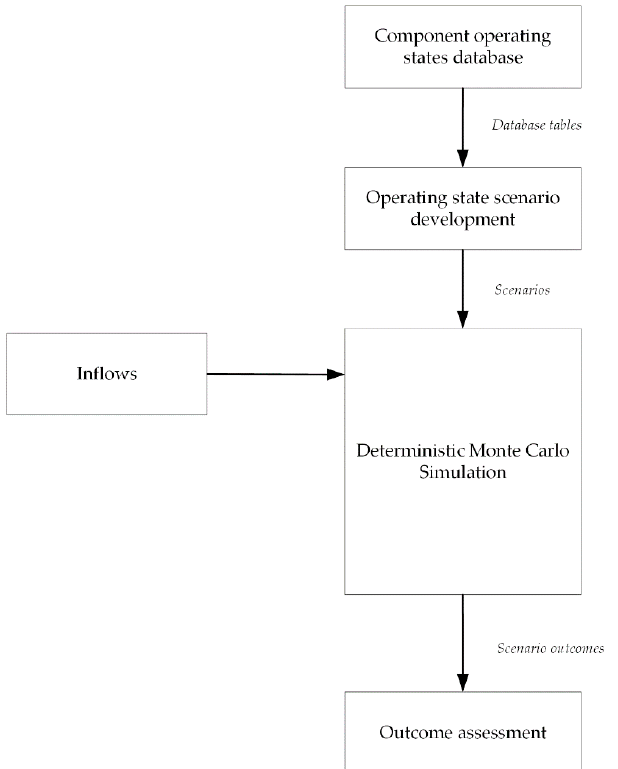
Figure 2. Methodology flow chart .